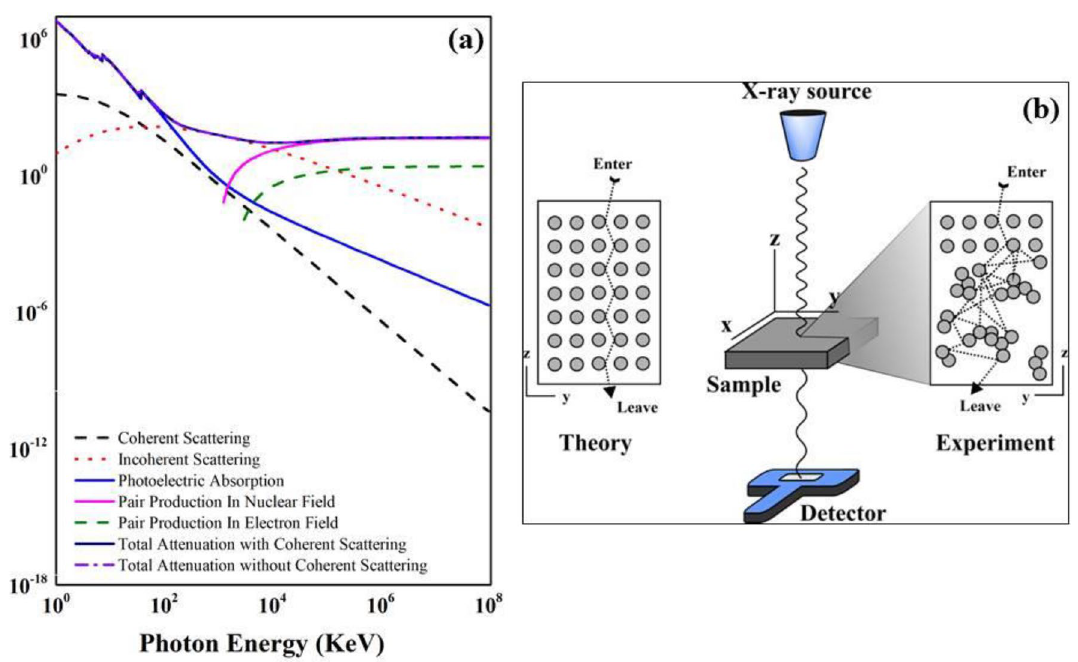
Figure 3. ( a ) XCOM full spectra of PBFC and ( b ) schematic illustration of PBFC composites when the photon incoming to the composite for theoretical based (theory) with uniform structure and for experimental condition with non-uniform